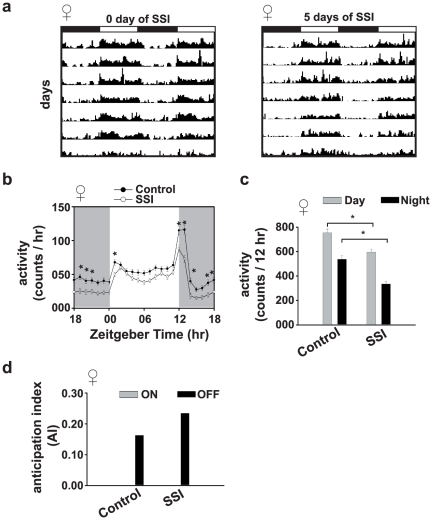
Socio-sexual interactions (SSI) cause reduction in overall activity in females.(a) Average actograms of females following 0 (control), or 5 days of SSI. (b) Activity profiles of females following 0, or 5 days of SSI. The activity of females is significantly reduced during morning and evening activity peaks and during most nighttime phases (p<0.05) in SSI females relative to control females. (c) Cumulative daytime and nighttime activity of females subjected to 0, or 5 days of SSI. (d) Anticipation to lights-on and lights-off measured as Anticipation Index (AI) of female flies subject to 0, or 5 days of SSI. All other details same as in Fig. 1.